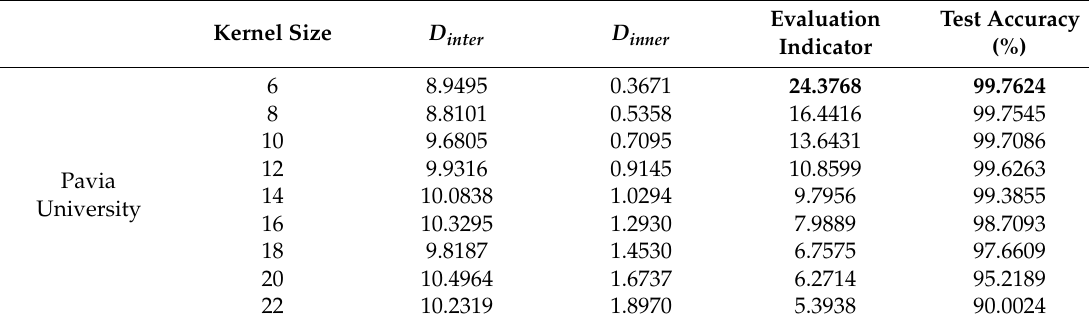
Table 4. The evaluation indicator value and the testing accuracy of K-means Net with different kernel sizes on Dataset 2.